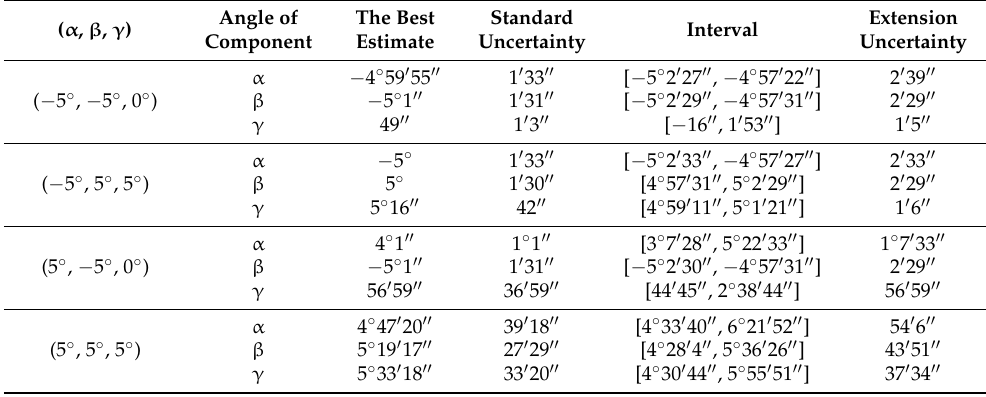
Table 3. Uncertainty evaluation table of specific angle measurement points.